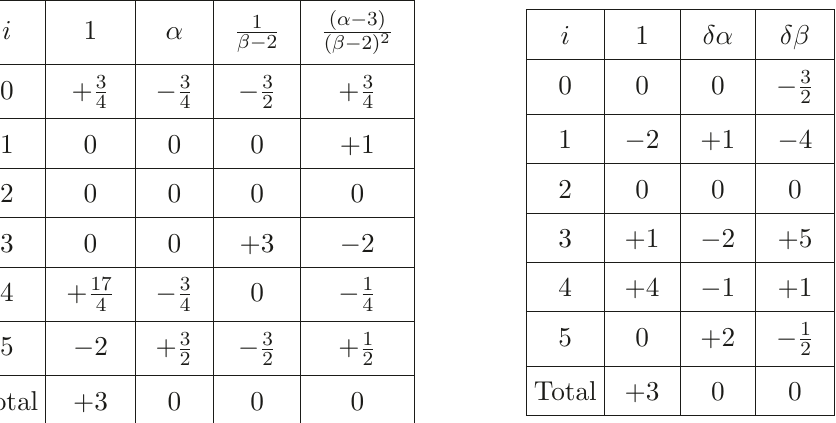
Table 1 . The left hand table gives the various gauge-dependent multiplicative factors for one graviton corrections to the massless scalar exchange force on flat space background using the full propagator (3.1) on the left, and for the first order expansion (3.5) on the right. The contribution of the 1PI 2-point function is i = 0 and the other values of i correspond to different source and observer corrections that are precisely defined in [16] and which are necessary to eliminate gauge